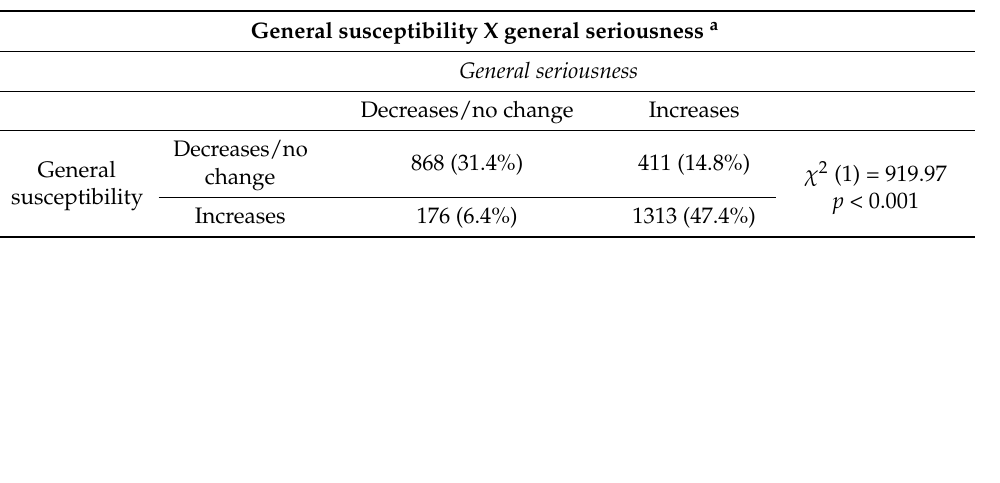
Table 2. Crosstabulations of personal and general seriousness and